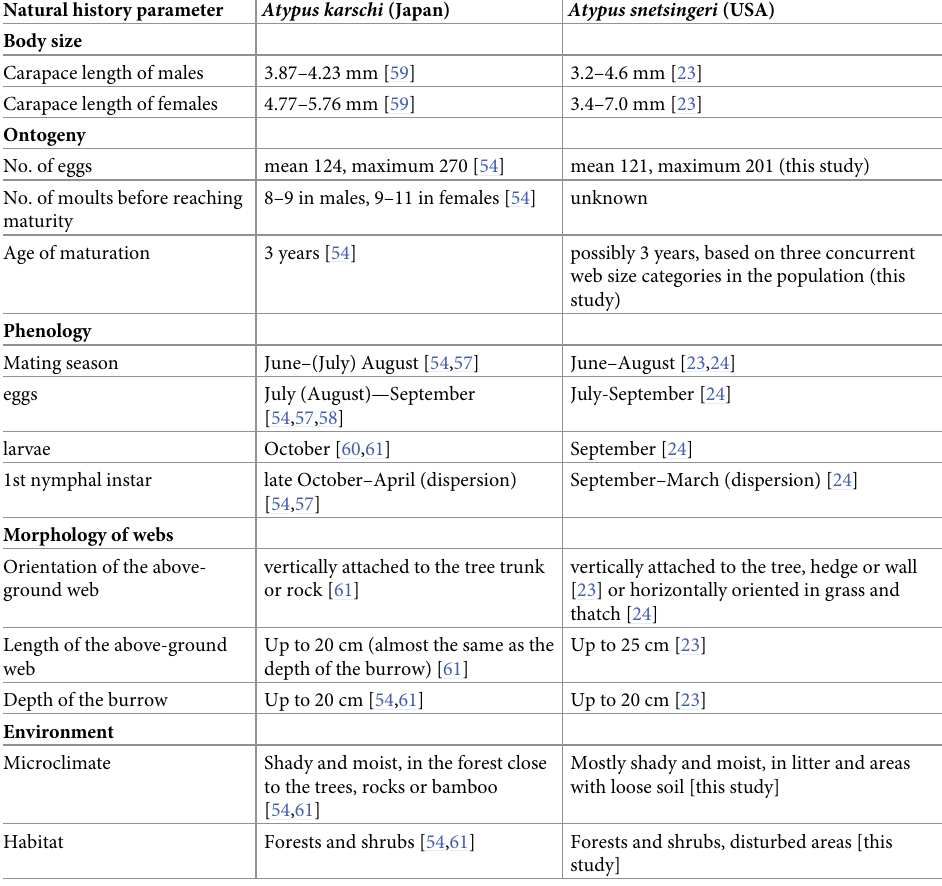
Table 1. Natural history parameters (body size, ontogeny, phenology, fecundity, morphology of webs, environ- ment) reported for Atypus karschi in Japan and for the introduced population known as A . snetsingeri in Pennsyl- vania,